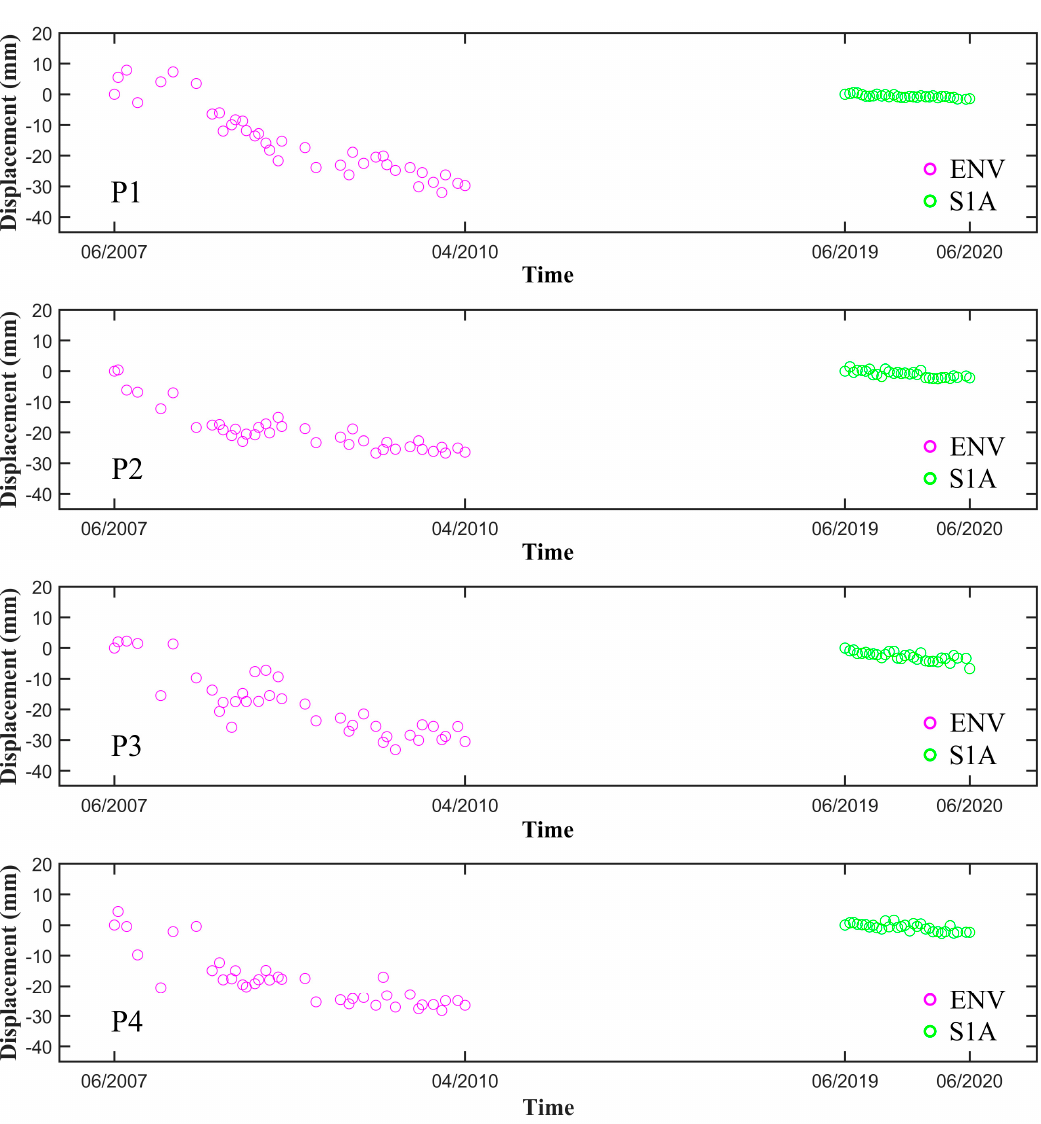
Figure 14. The plots of the ENV vertical deformation time-series (magenta circle) from June 2007 to April 2010 and the S1A vertical deformation time-series (green circle) from June 2019 to June 2020, at four points labeled as P1, P2, P3, and P4.